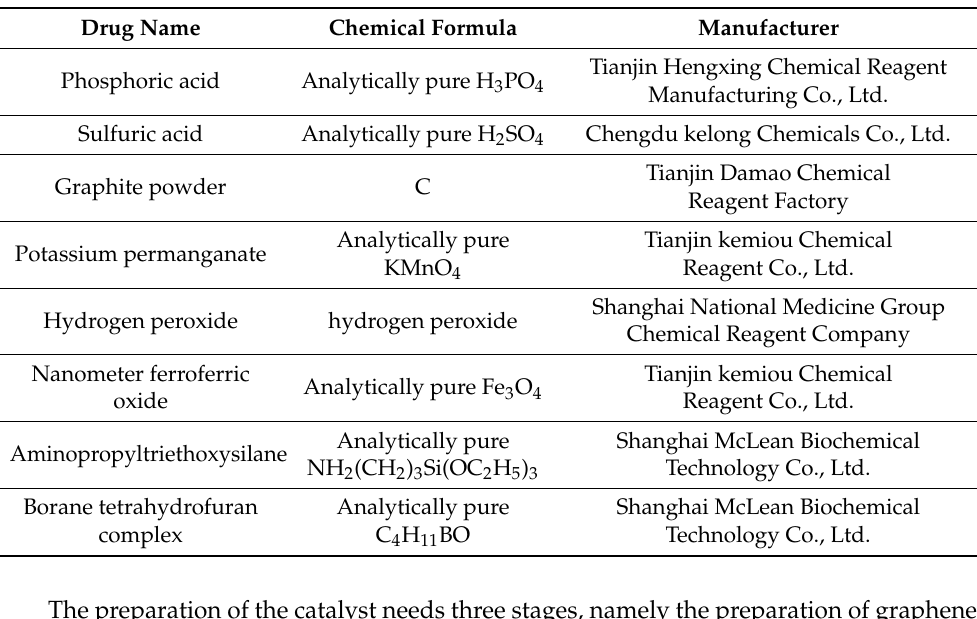
Table 2. Chemical reagents of the experiments.